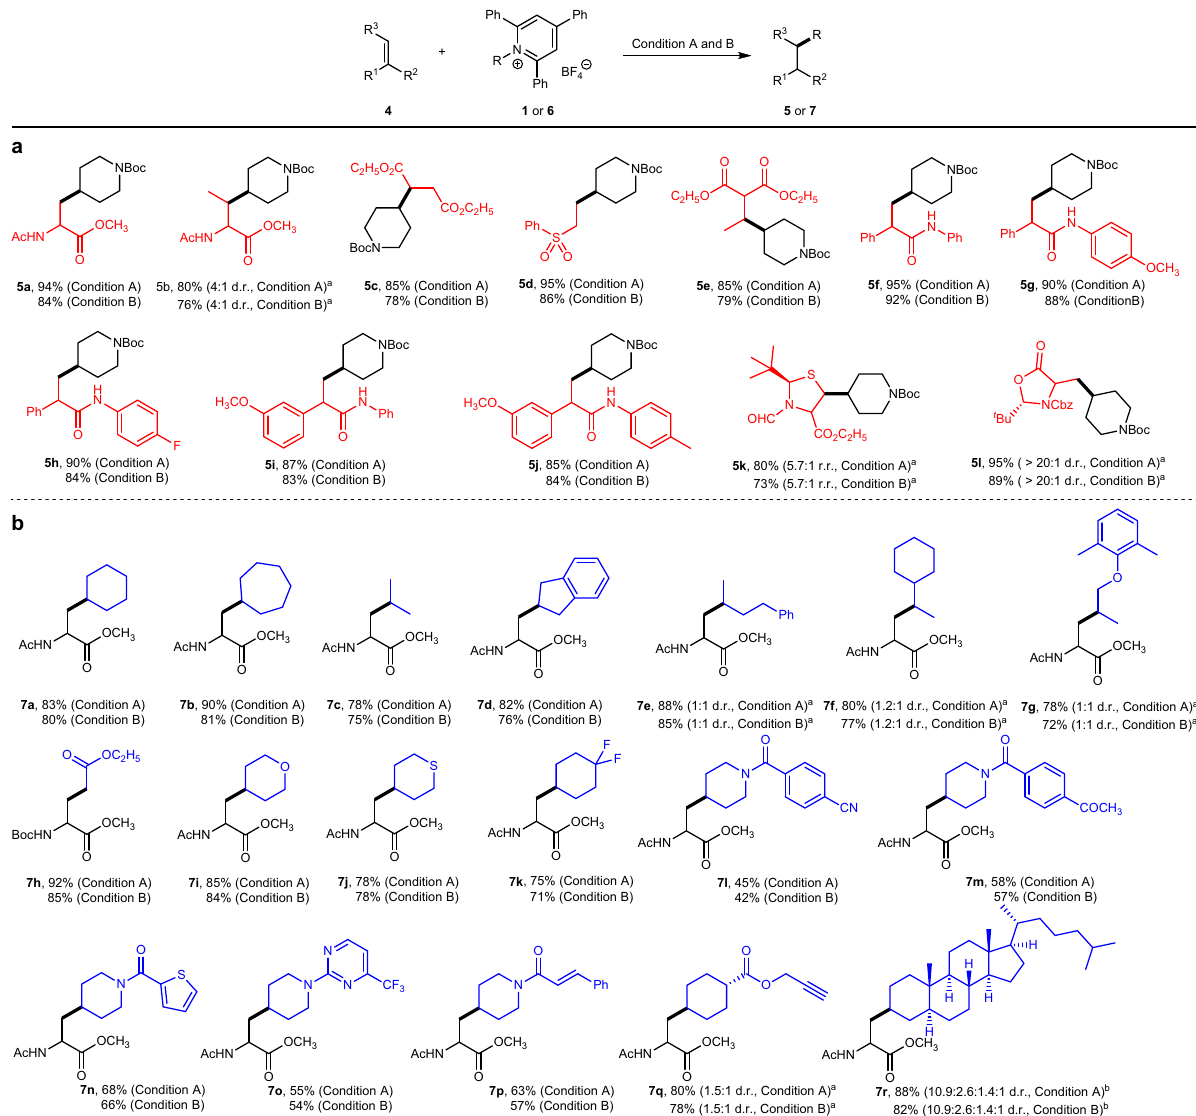
Fig. 2 Investigation of reaction substrate scope with respect to the alkenes and Katritzky salts. Reaction condition A: alkene (0.2 mmol), Katritzky salt (0.5 mmol, 2.5 equiv), Et 3 N (0.4 mmol, 2.0 equiv), K 2 CO 3 (0.2 mmol, 1.0 equiv), and H 2 O (6.0 mmol. 30 equiv) in CH 3 CN (3.0 mL), violet LED (24 W, 410-420nm), argon atmosphere, 12 h, room temperature. Reaction condition B: alkene (0.2 mmol), Katritzky salt (0.4 mmol, 2.0 equiv), PPh 3 (0.48 mmol, 2.4 equiv), KOCH 3 (0.6 mmol, 3.0 equiv), and H 2 O (5.0 mmol. 25 equiv) in acetone (3.0 mL), violet LED (24 W, 420 – 430 nm), argon atmosphere, 12 h, room temperature. Isolated yields after chromatographic puri fi cation. a Regio- or diastereomers were measured by 1 H NMR. b Diastereomers were measured by HPLC. a Substrates with alkenes (Condition A and B). b Substrates with Katritzky salts (Condition A and Condition